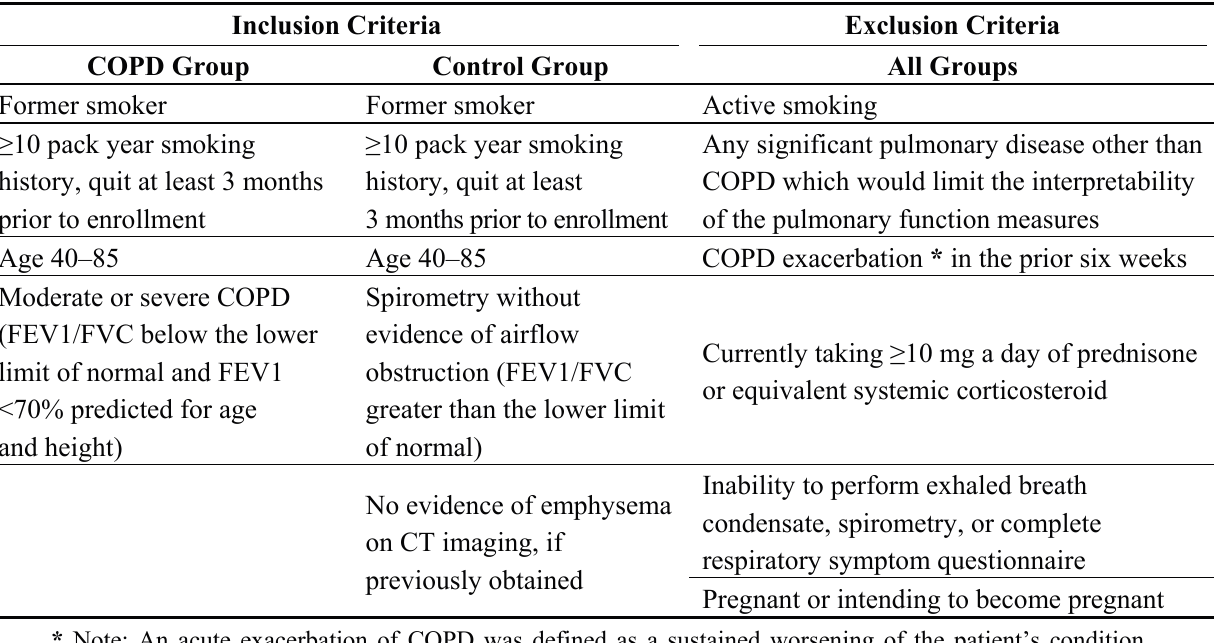
Table 1. Inclusion and exclusion